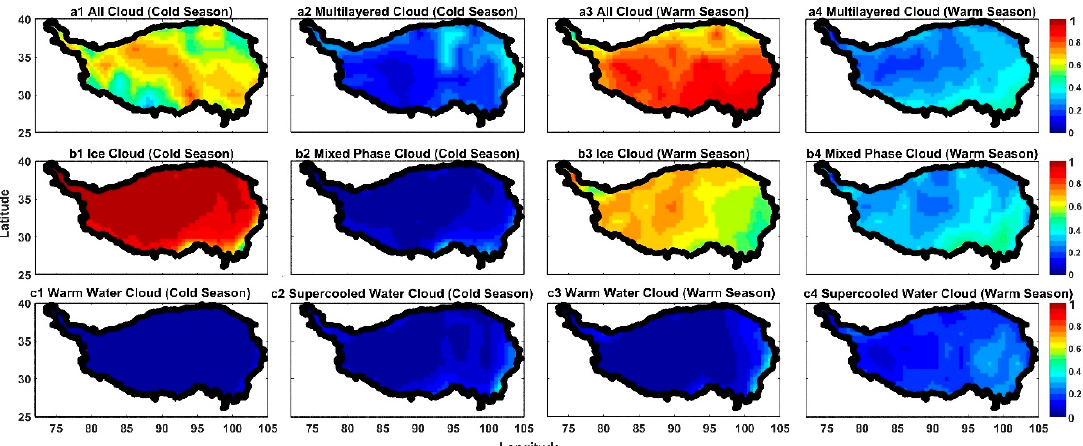
Figure 1. Four-year total cloud fraction and relative cloud fraction (RCF) of different cloud phases over the Tibet Plateau (TP). The spatial resolution is a 0.5 ◦ × 0.5 ◦ grid (the two columns on the left represent the cold season, and the two columns on the right represent the warm season). a1 and a3 represent the total cloud fraction in the cold and warm seasons, respectively. Others represent the RCF of different cloud phases. Here, each cloud phase is a single-layer plus multiple layers; for example, the ice cloud is the total ice